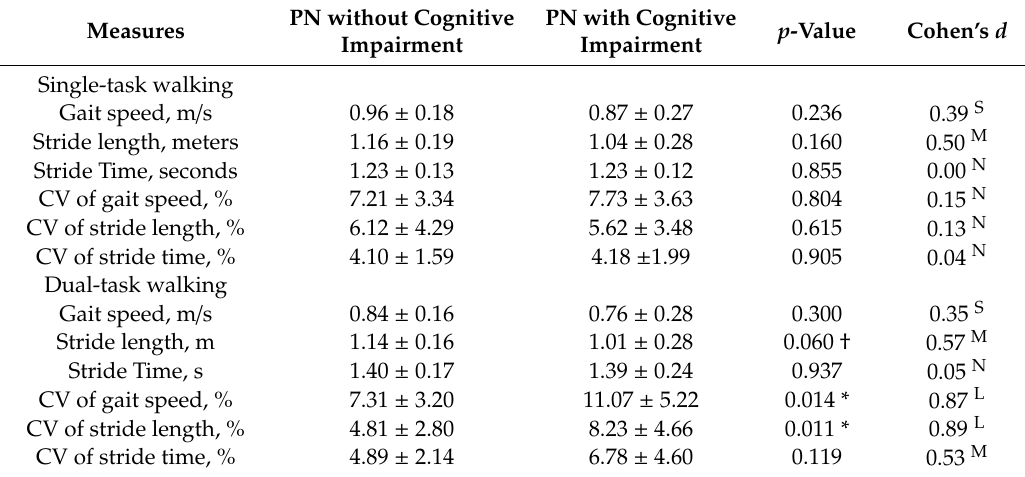
Table 2. Gait parameters and variability during single-task walking and dual-task walking for each group. CV—coe ffi cient of